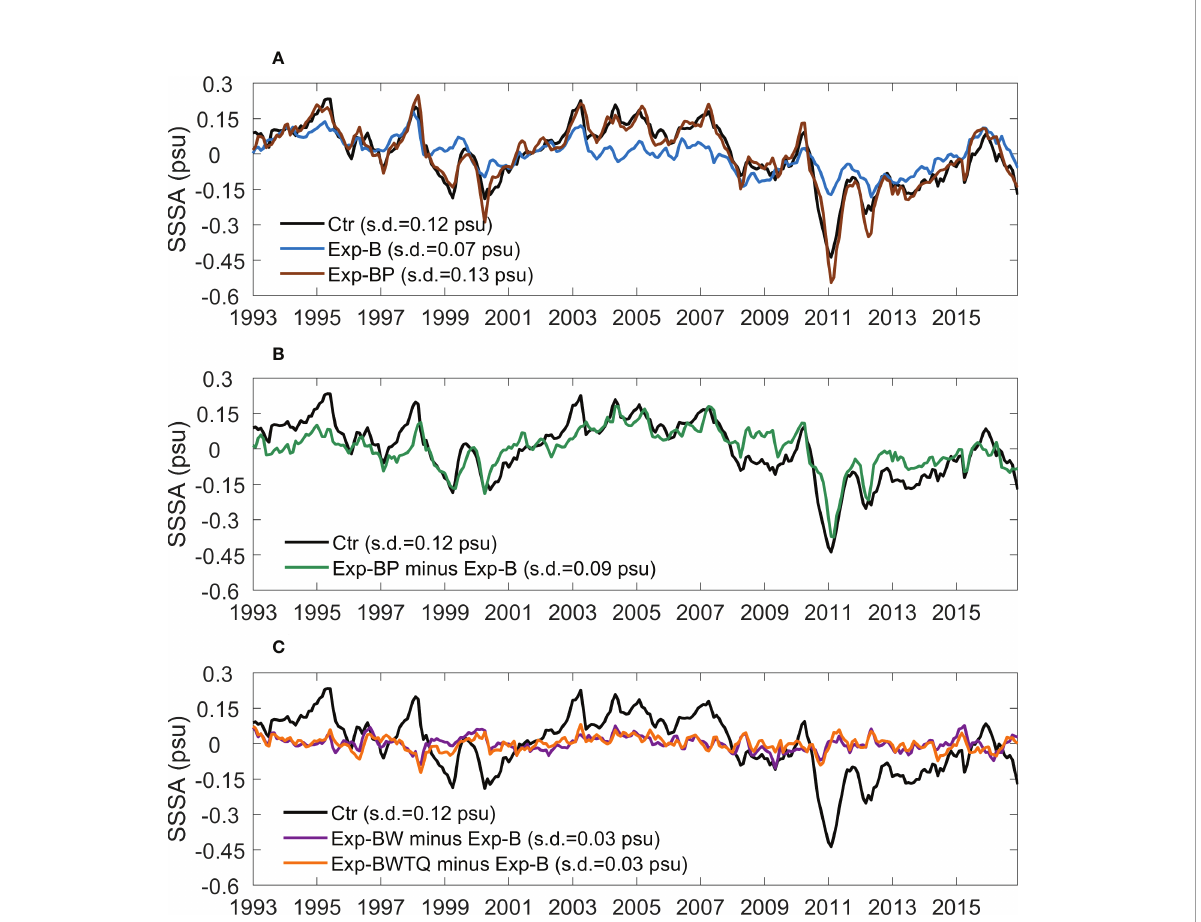
FIGURE 4 (A) Time series of monthly SSSA (in psu) averaged over the SEIO from Ctr (black), Exp-B (blue), and Exp-BP (brown). (B, C) As in (A) , but for Ctr (black), Exp-BP minus Exp-B (green), Exp-BW minus Exp-B (purple), and Exp-BWTQ minus Exp-B (orange). The standard deviation is also shown in the legend